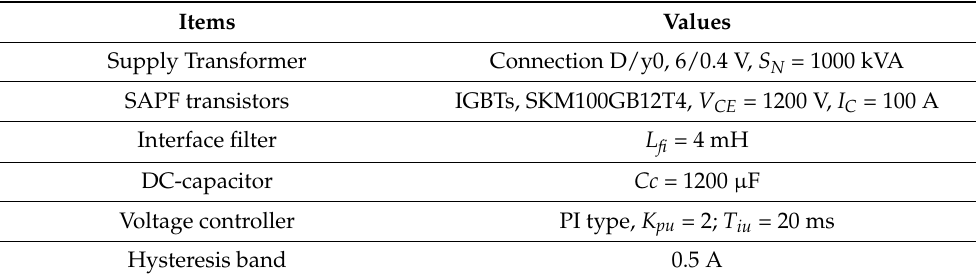
Table 1. The main parameters of the